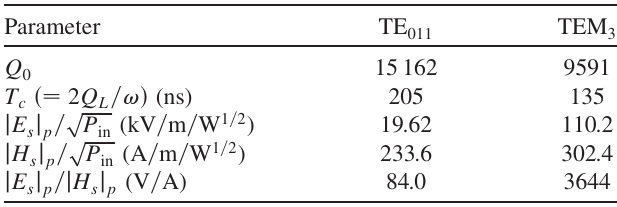
TABLE I. Dual-moded cavity design